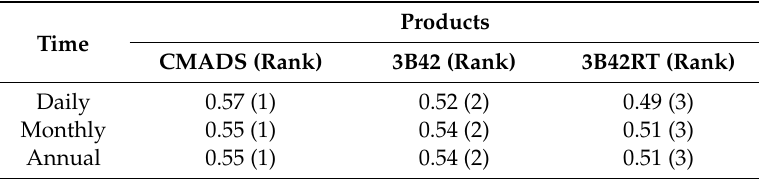
Table 3. Summary of SPAtial EFficiency (SPAEF) values for CMADS and TMPA daily, monthly and annual precipitation in the GRB. The metrics were calculated based on the mean precipitation at di ff erent temporal